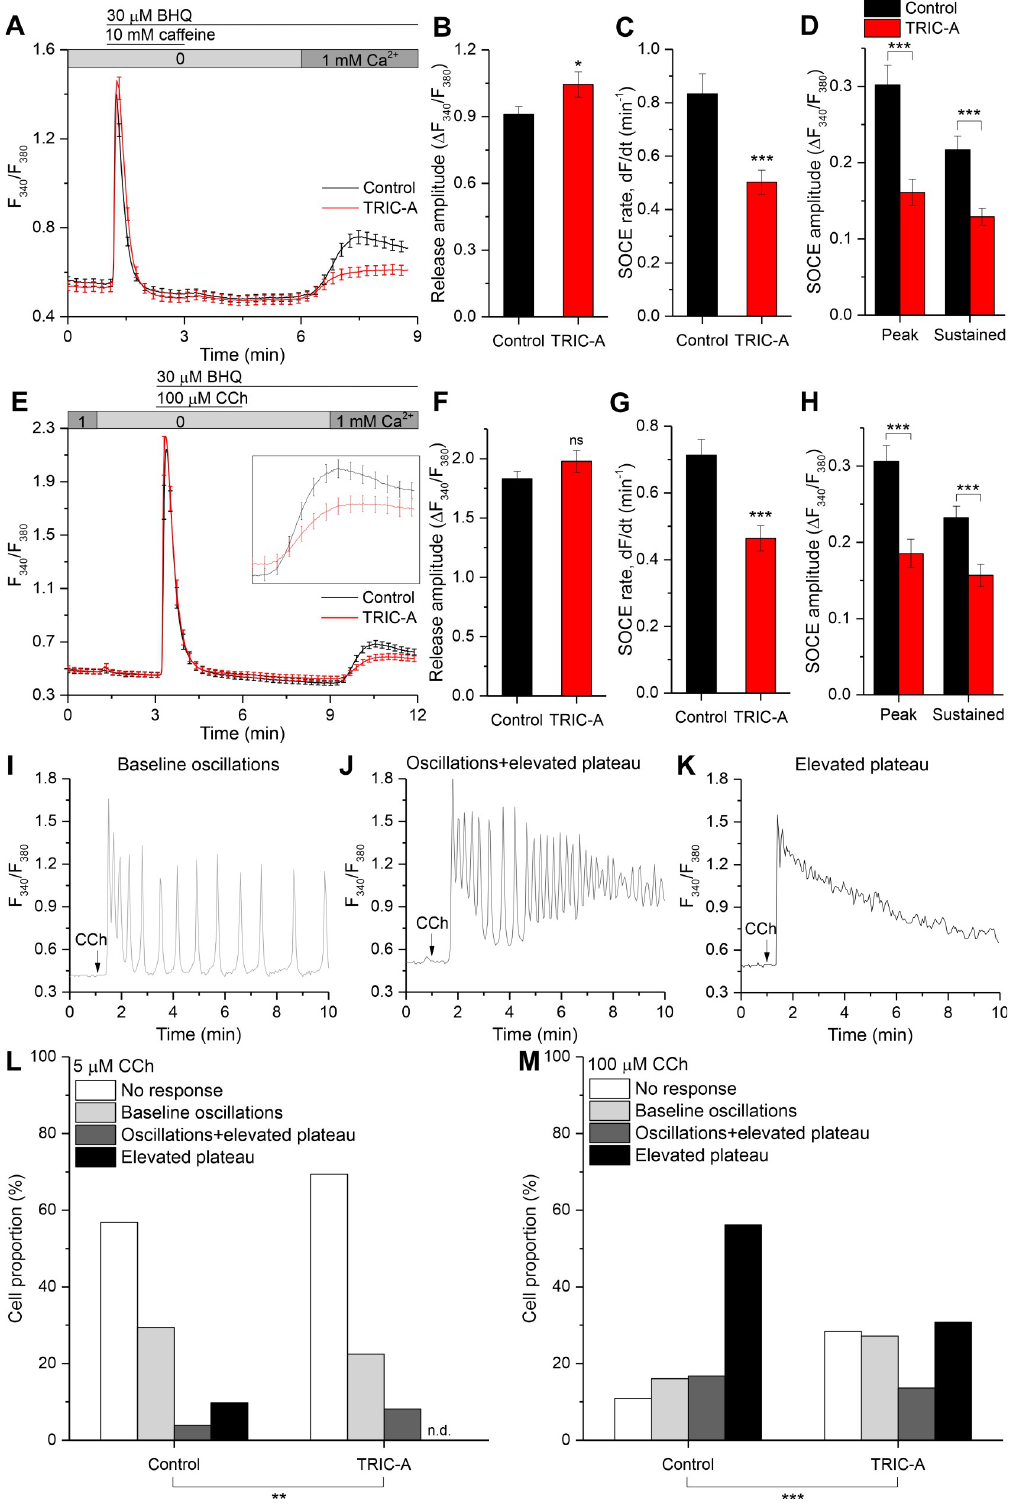
Fig 2. TRIC-A attenuates SOCE irrespective of RyR2 expression and dampens associated [Ca 2+ ] i responses to low and high stimuli levels. Average cytosolic Ca 2+ -sensitive Fura-2 traces in mCherry-ER-3 (control, black) or